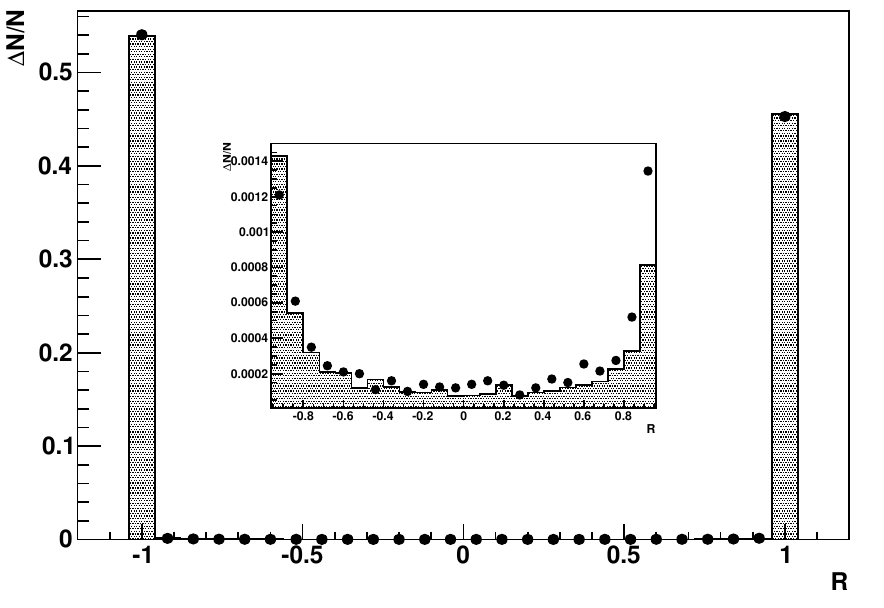
Figure 2 . The distribution of the separation parameter R for all collinear events ( e + e (cid:0) ! e + e (cid:0) , p (cid:25) + (cid:25) (cid:0) and (cid:22) + (cid:22) (cid:0) ) at the energy s =778 MeV. The insert depicts the same histograms in the region between the peaks. Dots { experiment, histogram { simulation. Histogram for MC simulation is sum of distributions for e + e (cid:0) ! (cid:22) + (cid:22) (cid:0) , e + e (cid:0) and (cid:25) + (cid:25) (cid:0) events. The contribution of each process to the histogram was calculated according to cross sections used in MCGPJ generator